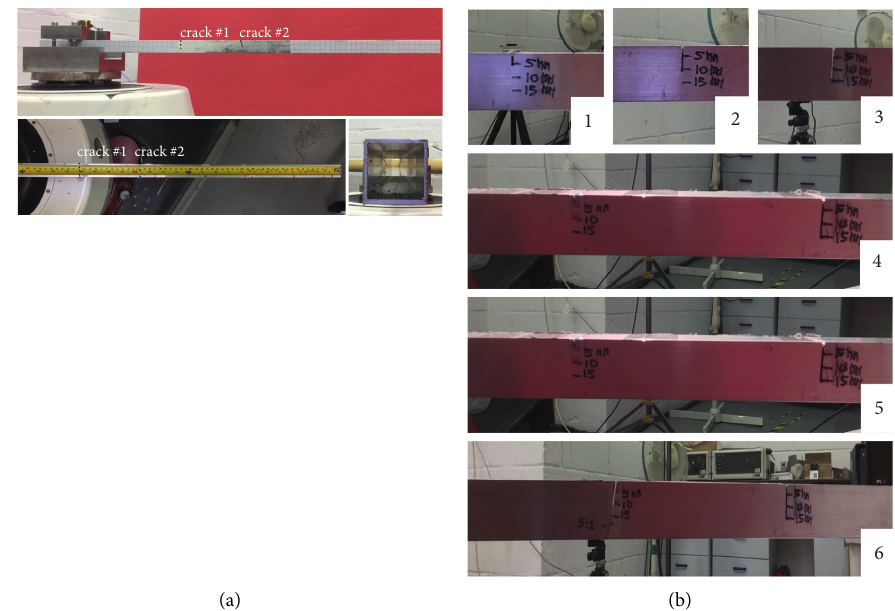
Figure 4: The damage scenarios considered. (a) Crack locations and angles. (b) The severity levels considered (the first case, with d is omitted).